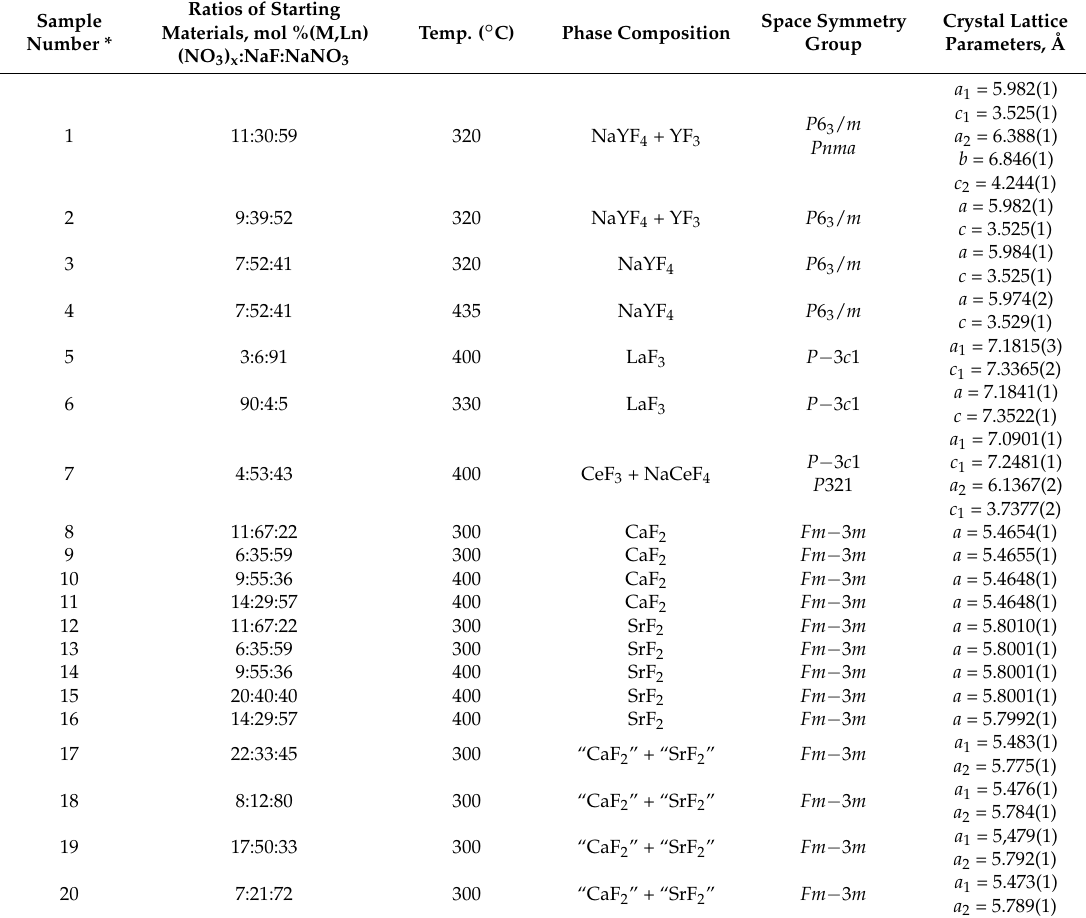
Table 1. Conditions and results of fluoride synthesis experiments.